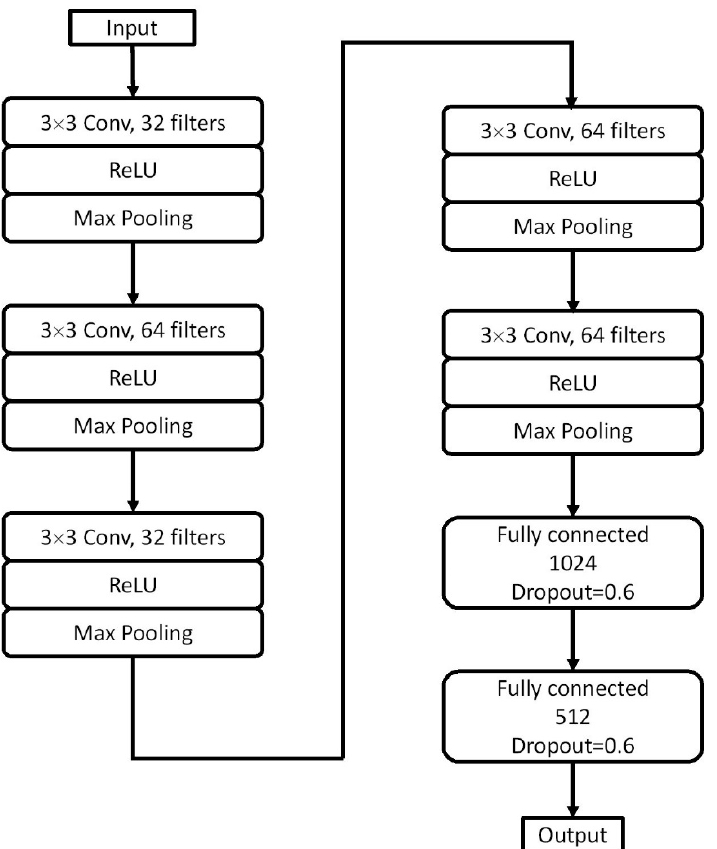
Figure 4. Convolutional neural network structure for distracted driving detection.